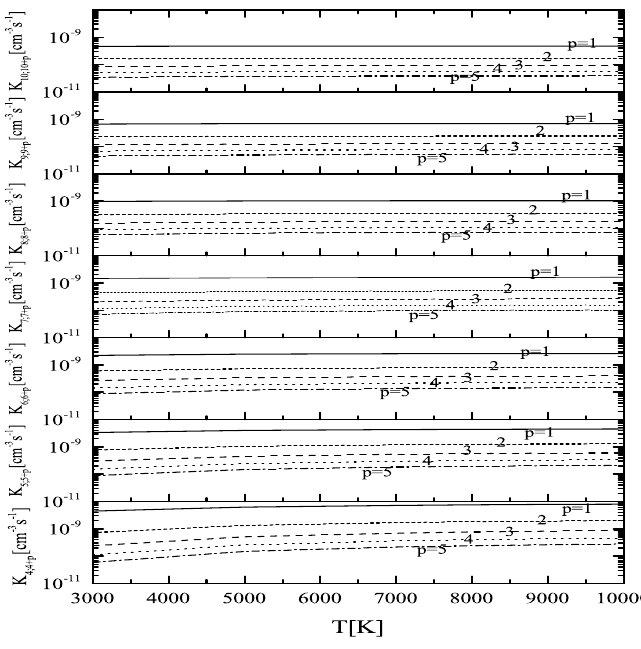
Figure 4. Collisional H*( n ) + H(1 s ) excitation rate coefficients K n ; n + p ( T ) for the transitions between the states with 4 ≤ n ≤ 10, 1 ≤ n (cid:48) − n ≤ 5 as a function of n and T . Here p = n (cid:48) − n